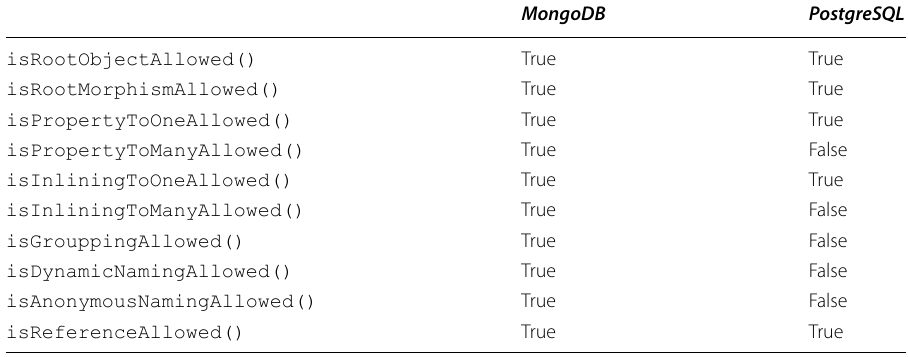
Table 2 Allowed complexity of mapping in MongoDB and